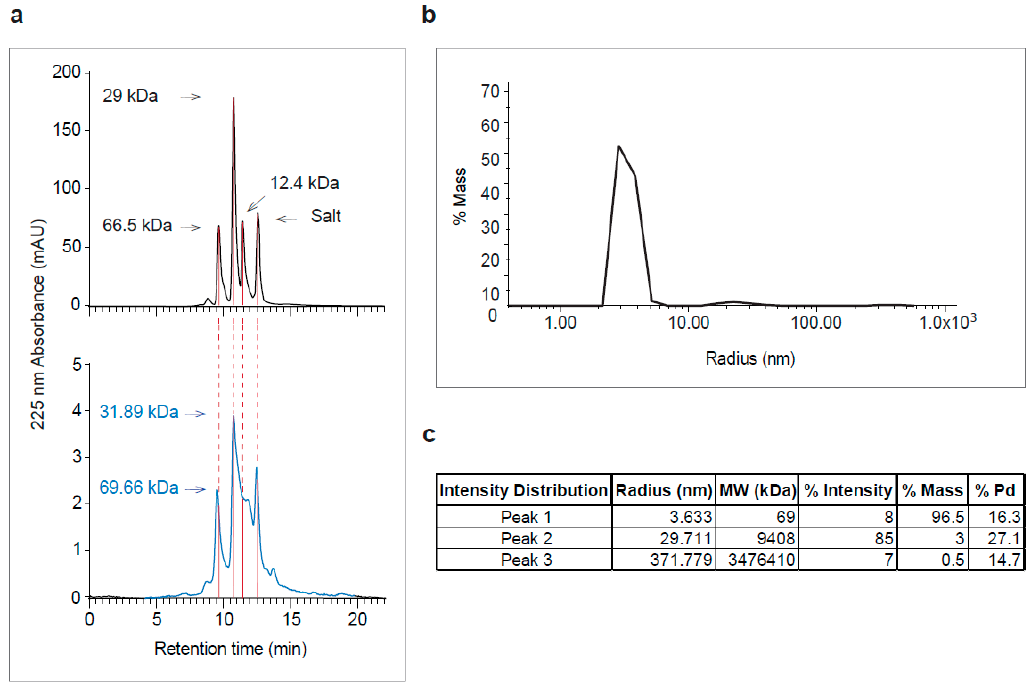
Figure 3. Analysis of purified recombinant A2-G by size exclusion chromatography (SEC) and dynamic light scattering (DLS). ( a ) Elution profiles of molecular weight standards (top) and of purified A2-G (bottom, in blue). Absorbances at 225 nm (y-axes) are shown for different retention times (y-axes) with indicated molecular weights in kDa. ( b ) DLS profile of purified A2-G (y-axis: % mass; x -axis: radius-nm) are shown. ( c ) Summary of peak features (radius, molecular weight, % intensity, % mass and % Pd).